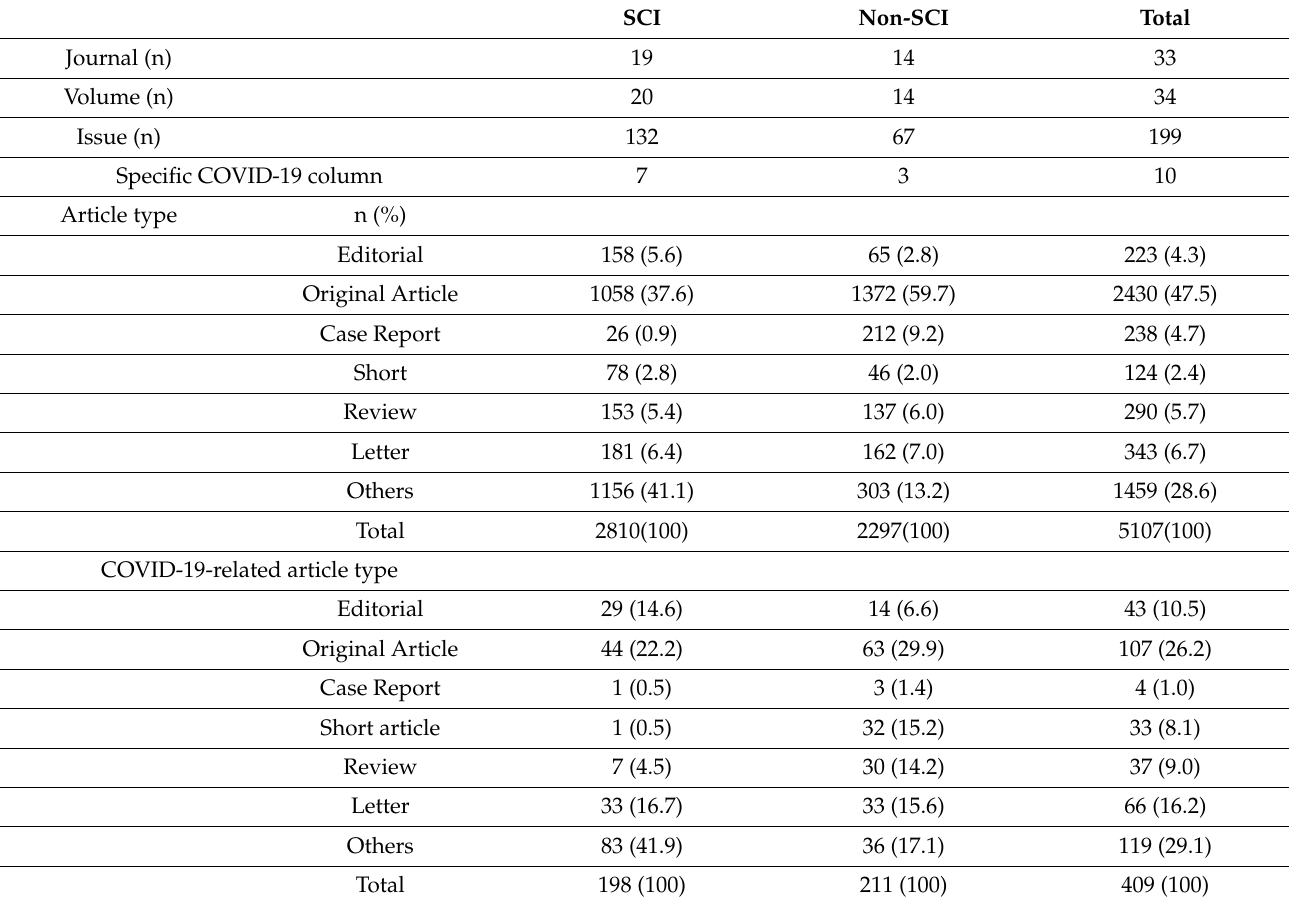
Table 2. General profiles of family medicine journal publication from PubMed in